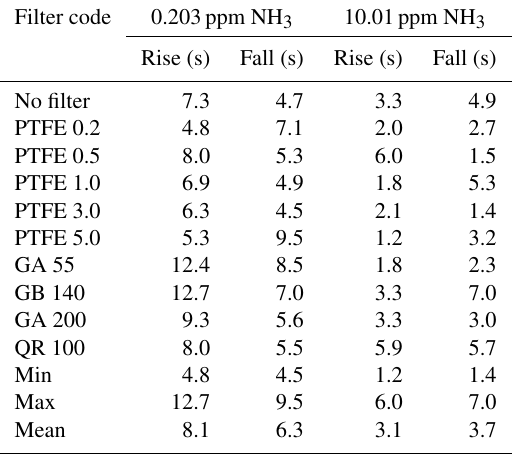
Table A2. The rise (1 /e response time) and fall (1 /e response time) times (s) of the CRDS analyzer for measurements of NH3 concen- trations (0.203 and 10.01ppm) with or without external inlet partic- ulate filters during laboratory testing. For filters detail see Table 1.